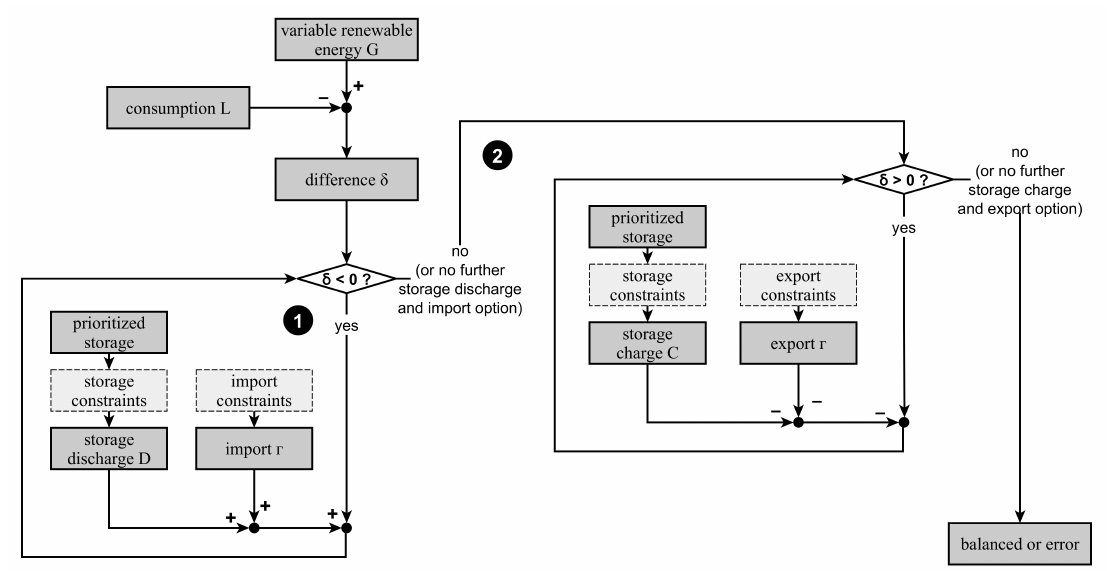
Figure 8. Schematic diagram of the hierarchical flow of the energetic balancing process according to Bussar et al.